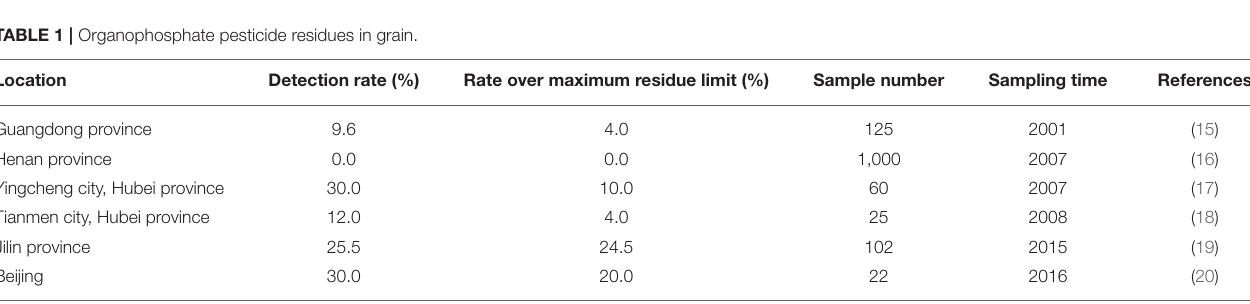
TABLE 1 | Organophosphate pesticide residues in grain. Location Detection rate (%) Rate over maximum residue limit (%) Sample number Sampling